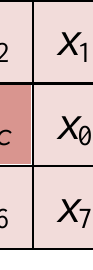
Figure 5. Pixel and its eight neighborhoods.